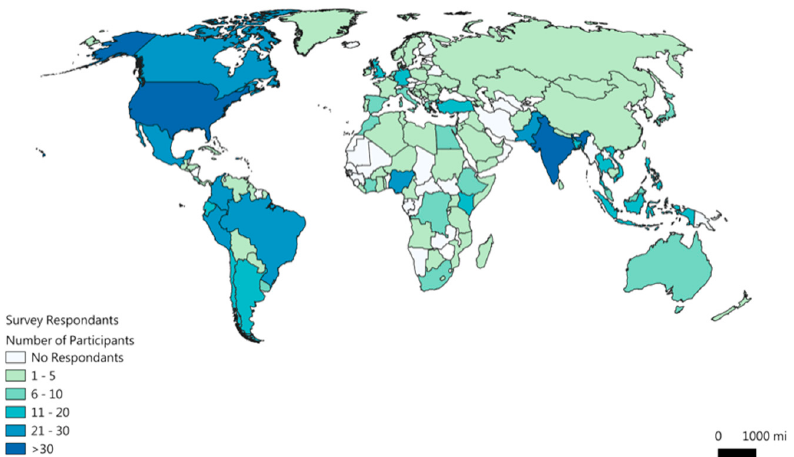
Figure 2. Number of ARSET survey respondents per country. There were participants from 117 countries and 50 states within the United States (US). The greatest numbers of participants were from the US (26%) and India (12%) ( N = 1024).